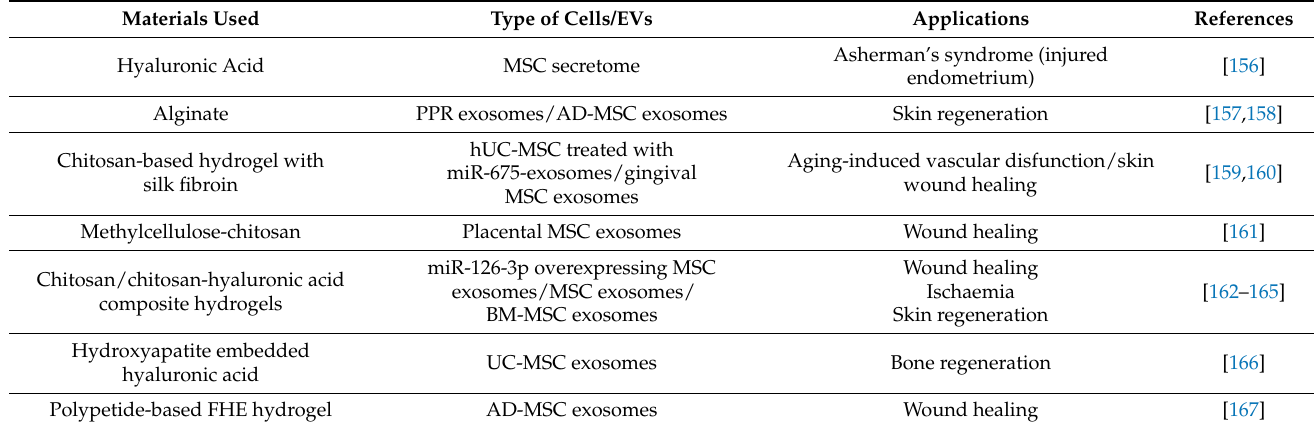
Table 3. Commonly used hydrogel-based systems for the delivery of